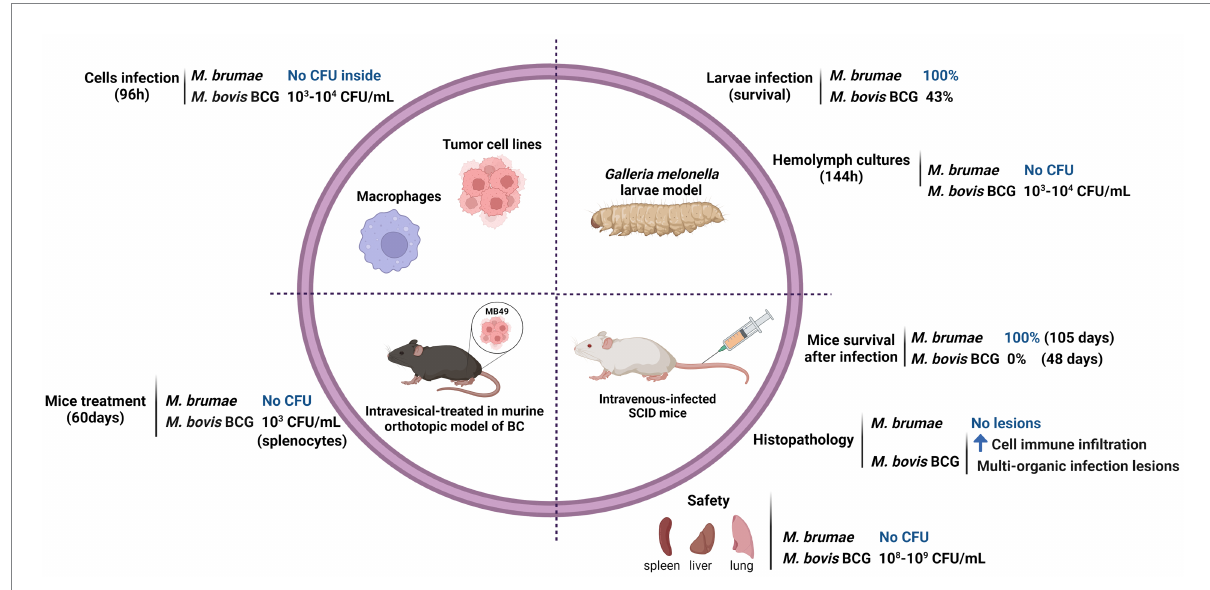
FIGURE 1 Safety profile of Mycobacterium brumae . Comparison of the pathogenicity and toxicity between M . brumae and M . bovis BCG Connaught. Summary of the results obtained in different in vitro studies infecting macrophages (Noguera-Ortega et al., 2016b) and bladder cancer cell lines (Noguera-Ortega et al., 2016a), and in vivo studies in different animal models: intrahemacoelical infection of Galleria mellonella (Bach-Griera et al., 2020), intravesical instillations in orthotopic murine model of bladder cancer (Noguera-Ortega et al., 2016a,b,c), and intravenous infection in SCID mice (Bach-Griera et al., 2020). Blue rising arrow (high cell immune